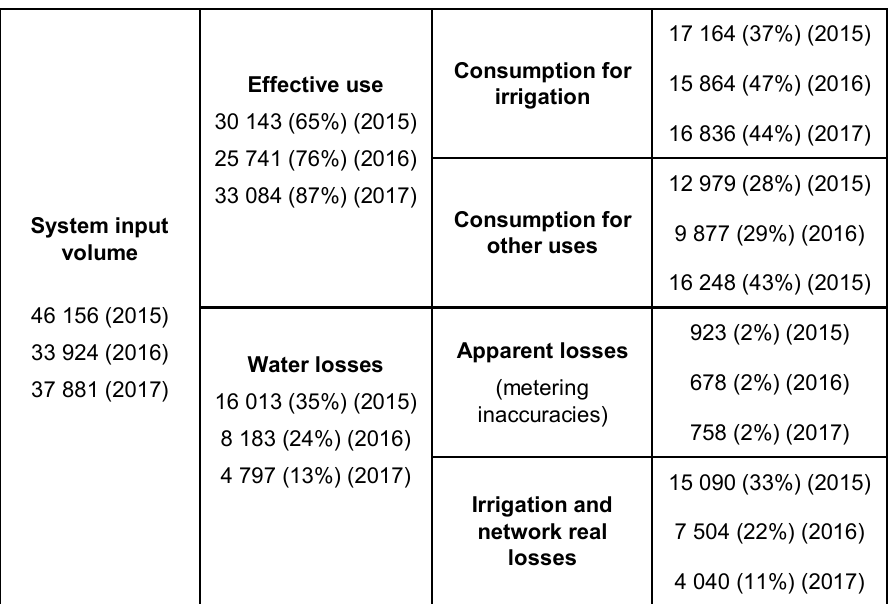
Figure 8. Water Balance for Case study 2 in 2015, 2016 and 2017 (m 3 /year).